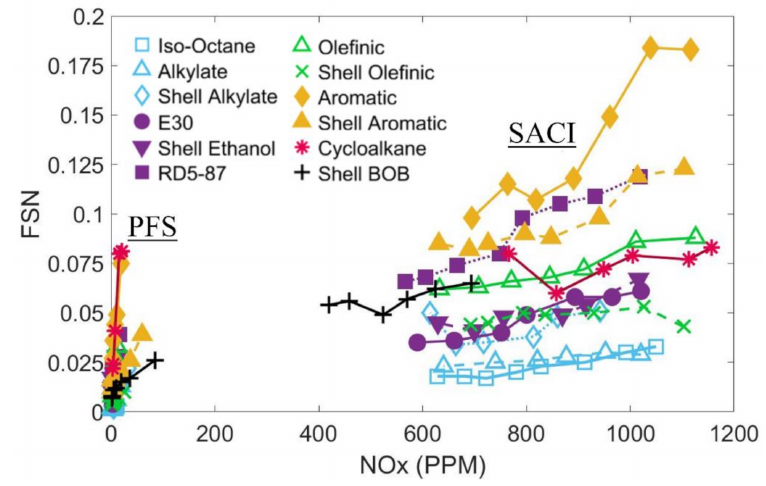
Figure 11. Soot-NOx tradeoff for PFS and SACI